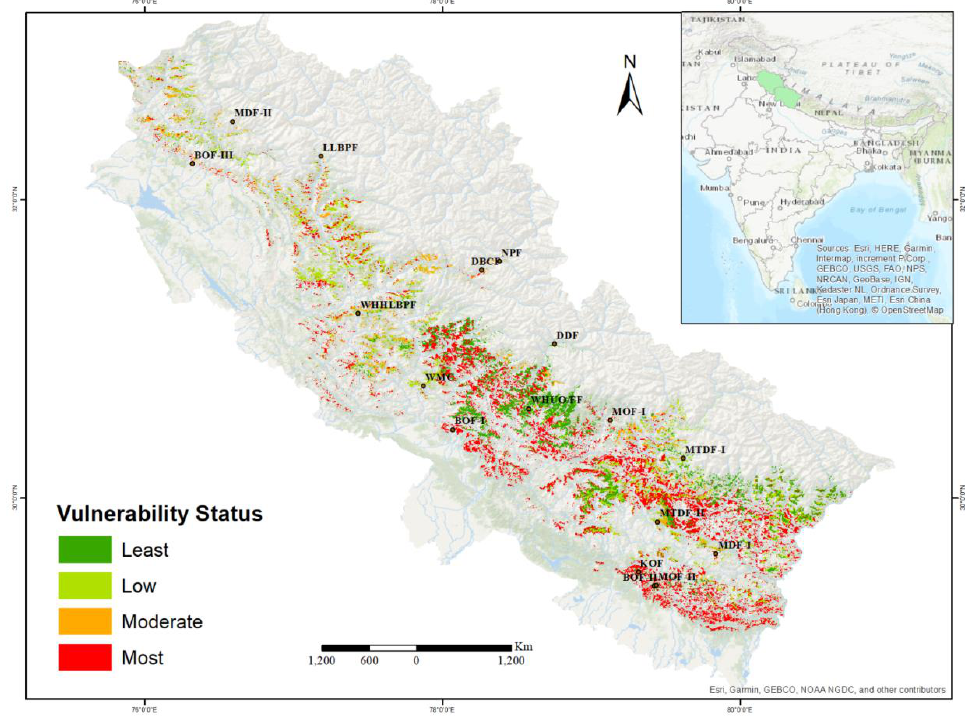
Figure 2. Vulnerability status of the selected forests.